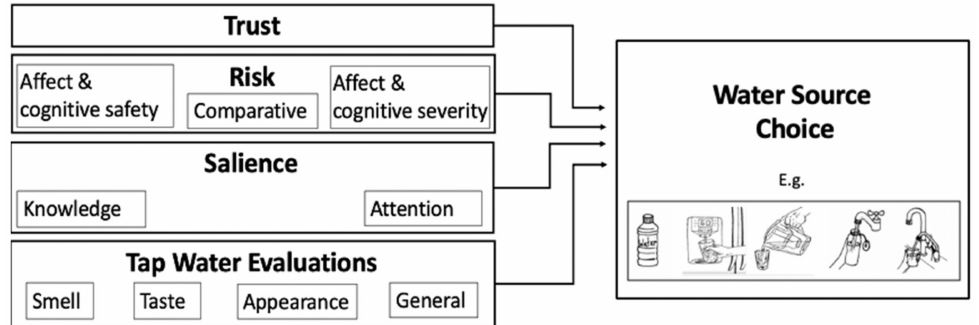
Figure 1. The water source, or sources, that individuals choose to drink from is a function of their trust in the utility to deliver safe drinking water to them, salience of their home water quality, risk judgments of water safety (alone and relative to bottled water), emotional concern, severity of consequence should their water become unsafe, and quality judgments of their tap